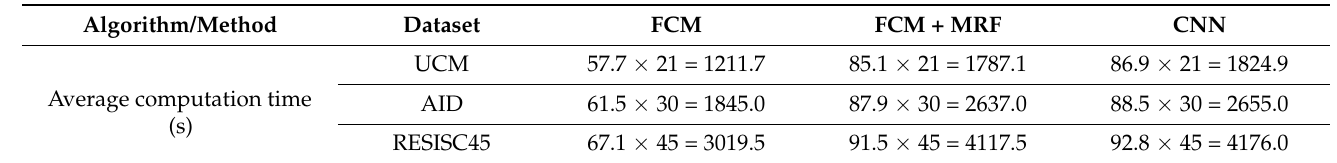
Table 6. Computation time comparison of proposed segmentation technique with CNN over bench- mark